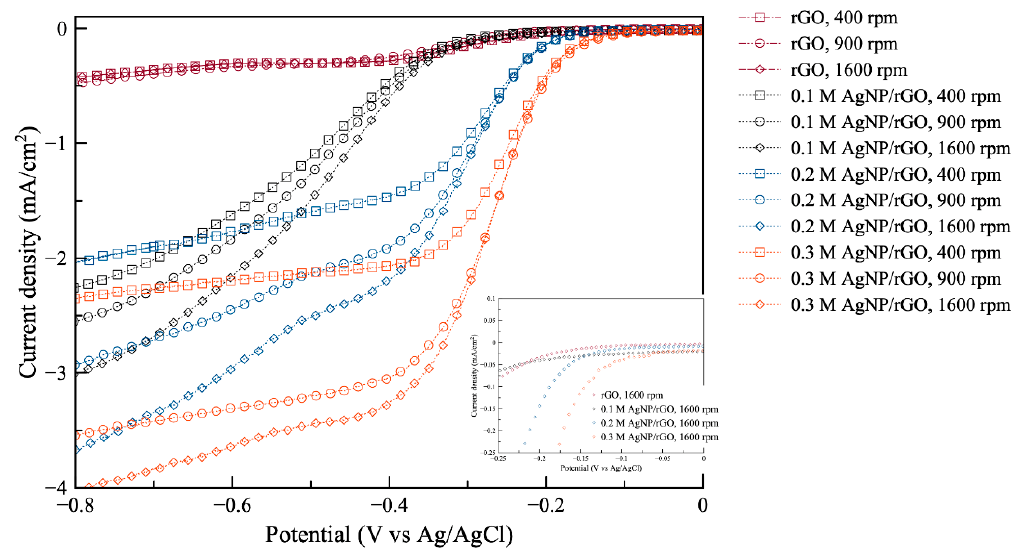
Figure 4. Oxygen reduction reaction (ORR) polarization curves of the prepared samples: rGO, 0.1 M AgNP / rGO, 0.2 M AgNP / rGO, and 0.3 M AgNP / rGO at 400, 900, 1600 rpm. The inset shows a magnified part of the original